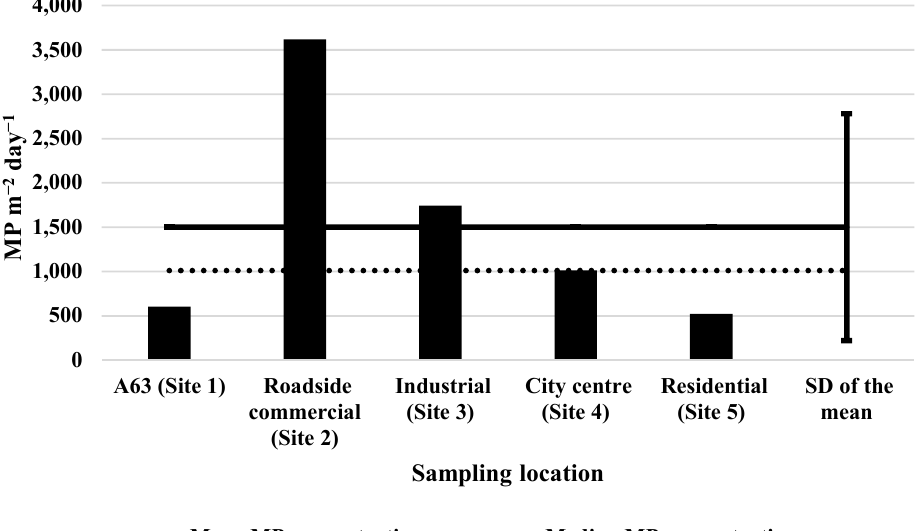
Figure 5. MP levels from the sampling month of February 2020, across all five sampling sites (after LOD LOQ adjustments). The solid line represents the mean MP level (MP m − 2 day − 1 ) from the five sampling sites, and standard deviation of the mean included. The dotted line represents the median MP level (MP m − 2 day − 1 ) from the five sampling sites.